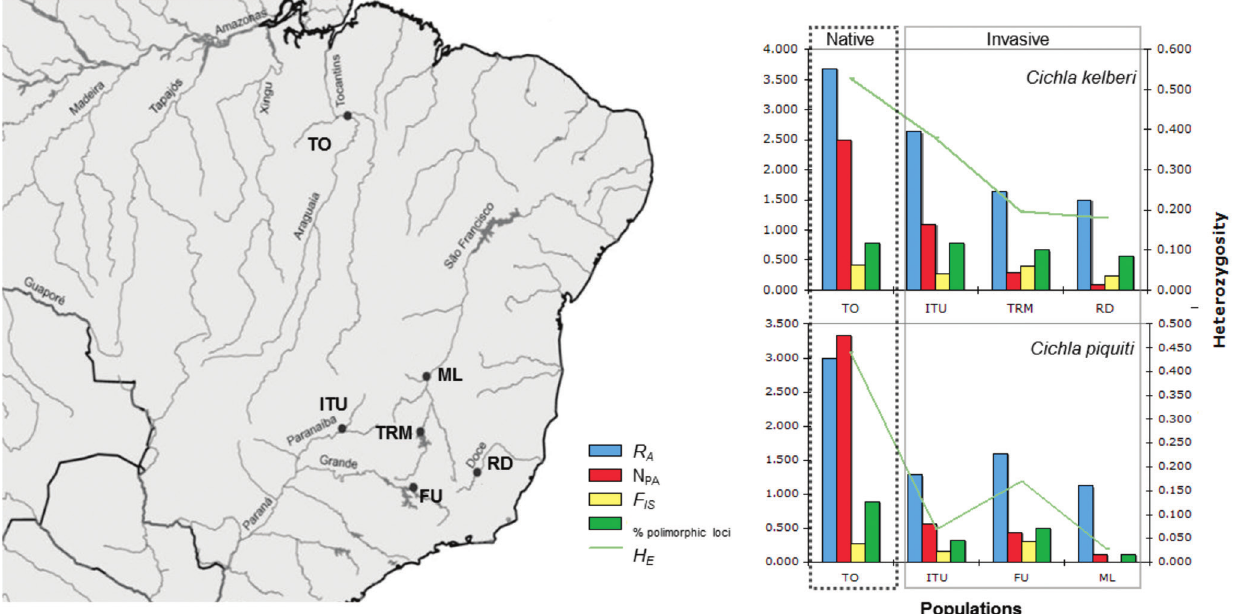
Fig. 1. River basins in eastern and northern Brazil showing sample sites and genetic parameters of native and introduced populations: Allelic richness (R ), Nei’s genetic diversity (H ), Number of private alleles (N ) and percentage of polymorphic A E PA loci . Samples sites: TRM - Três Marias reservoir and ML - Marginal Lake (both in the São Francisco River); ITU - Itumbiara reservoir (Paraná River - upper Paraná River basin); RD - Rio Doce (Dom Helvécio Lake - Doce basin); FU - Furnas reservoir (Grande River - upper Paraná River basin); TO - Tucuruí reservoir (Tocantins River - Amazon